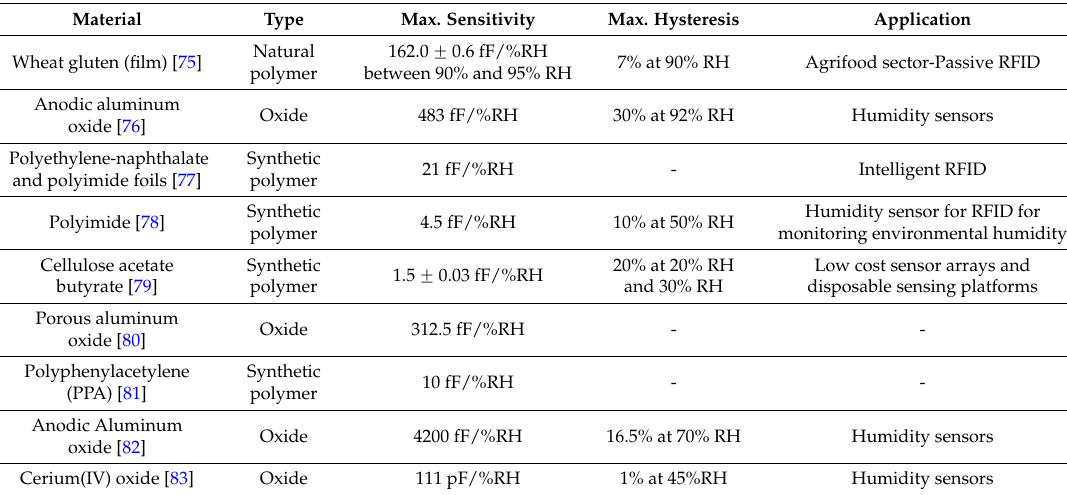
Table 5. Humidity sensor characteristics found in literature